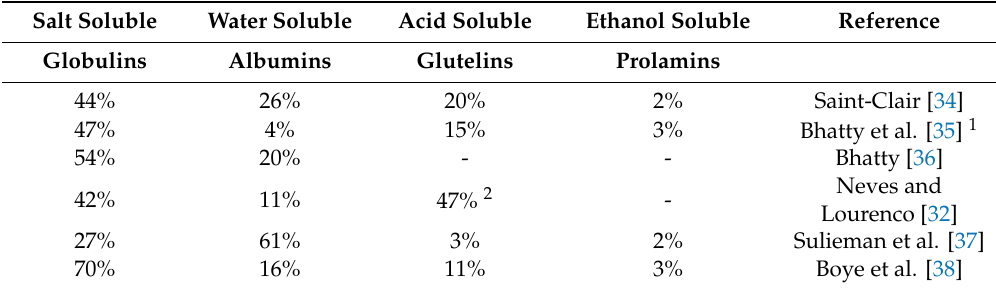
Table 3. Summary of reported analyses of cultivated lentil seed storage protein fractions (%) based on their solubility in di ff erent solvents.